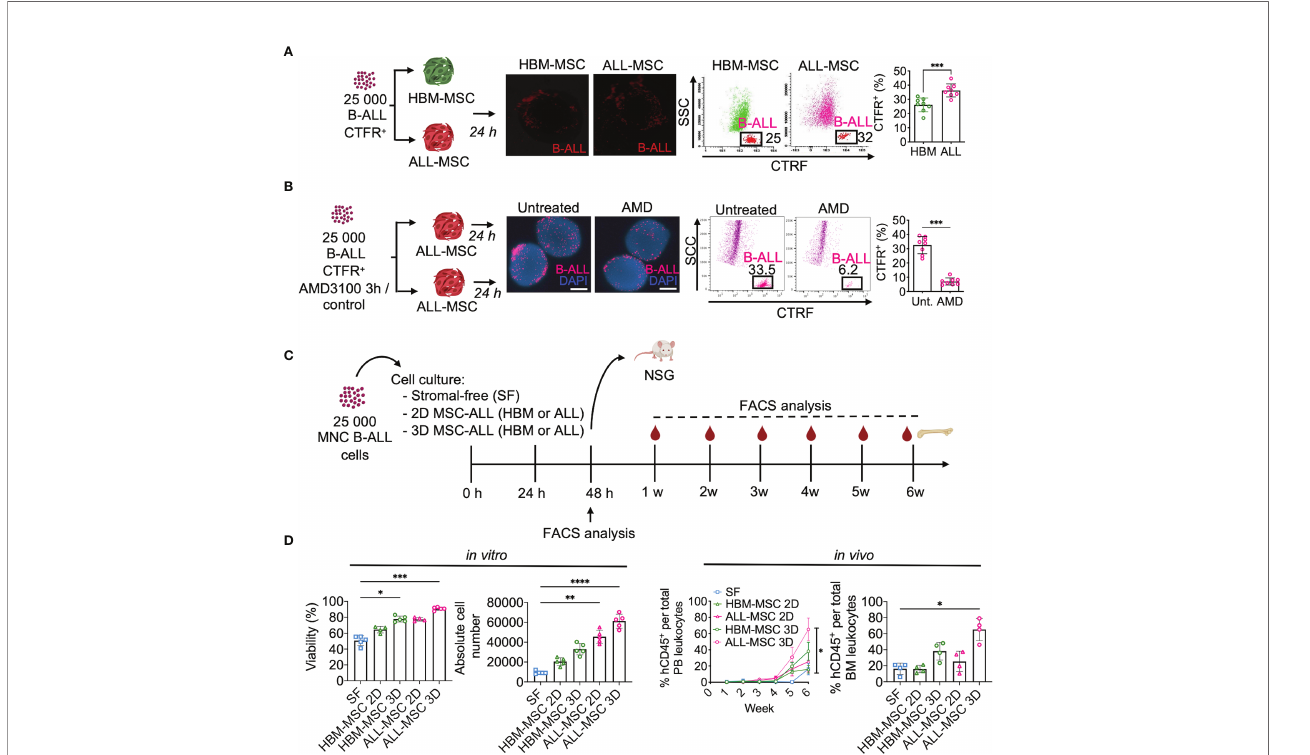
FIGURE 2 | Mesenchymal stromal spheroids support primary leukemogenic B-ALL cells. (A) Primary sorted B-ALL CD10 + CD19 + blasts were labeled with CTFR and co-cultured with HBM-MSC or ALL-MSC spheroids. After 24 h, spheroids were washed and analyzed by fl uorescence microscopy and FACS. CTFR + colonizer cell frequencies determined upon enzymatic digestion ( n = 7). (B) CTFR-labeled primary B-ALL cells were treated with a CXCR4 inhibitor (AMD3100) 5 mM for 3 h and then co-cultured within PDLS. Upon 24 h, CTFR + content was determined by FACS ( n = 8). (C) Schematic representation of experimental design, 25,000 mononuclear cells from B-ALL patients were cultured in SF conditions, or co-cultured with HBM- or B-ALL-MSC monolayer (2D) or spheroids (3D). (D) Cell viability was analyzed by fl ow cytometry upon 48 h and absolute cell number was determined ( n = 5) (left). Leukemic cells from independent experiments were harvested at 48 h of culture and transplanted into NSG mice. Human engraftment of hCD45 + was weekly monitored in PB by FACS and engraftment in BM was determined 6 weeks after transplantation ( n = 4) (right). MSC, mesenchymal stromal cell; HBM, healthy bone marrow; B-ALL, B-cell acute lymphoblastic leukemia; CTFR, Cell Trace Far Red; FACS, Fluorescence-activated cell sorting; SF, stromal-free; PB, peripheral blood. *P < 0.05; **P < 0.01; ***P < 0.001, ***P < 0.0001. Error bars represent